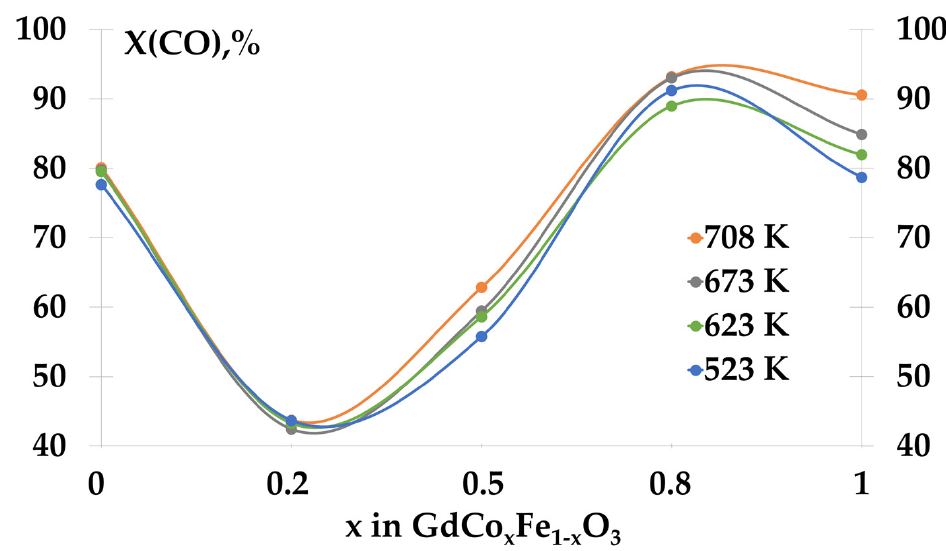
Figure 5. Temperature dependences of CO conversions when the reaction is carried out at a CO:H 2